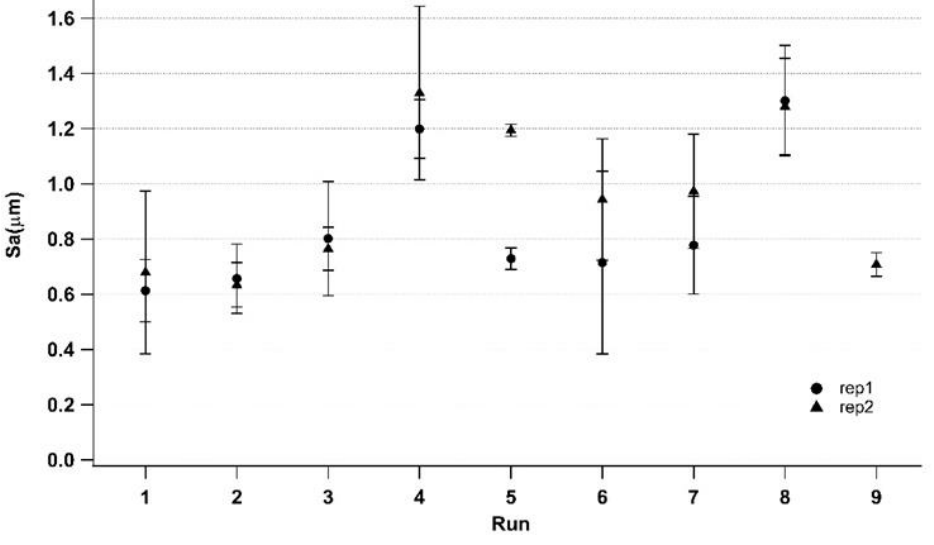
Figure 11. Sa and corresponding standard deviations for each treatment of the two replications. Due to the compliance with the normal distribution, the homogeneity of variances conditions, and considering previous results (Figure 4), the ANOVA analysis was carried out on the Sa parameter. For the sake of completeness, it should be noted that the Sq parameter is redundant compared to Sa, while Ssk and Sku show a wider standard deviation but similar average value between low-quality samples (run_8) and the one produced in a steady state condition(run_36). Figure 12 shows the Pareto chart of the standardized effects (a) and the main-effect plots (b) for the process parameters considering Sa as the main quality index. Pareto chart indicates that melt and mold temperatures and their interaction are responsible for the statistically significant threshold (red dotted line) at the chosen α value (0.05), and, thus, they are the most effective parameters in the IM process. Therefore, melt temperature confirms the result obtained by analyzing the components length as the most effective parameter on micro cavities molding. However, the Sa analysis also demonstrates the significant role played by mold temperature, as suggested by main- effect plot (Figure 12b). Indeed, this process parameter favours surface covering before melt freezing. The injection velocity falls in correspondence to the statistically significant threshold, and its importance in the process has been already stressed in the initial sections. The central point falls under a lower Sa value, pointing out an overall non-linear trend. The main-effect plots demonstrate the importance of setting high parameters levels for filling micro-mold cavities and achieving satisfying